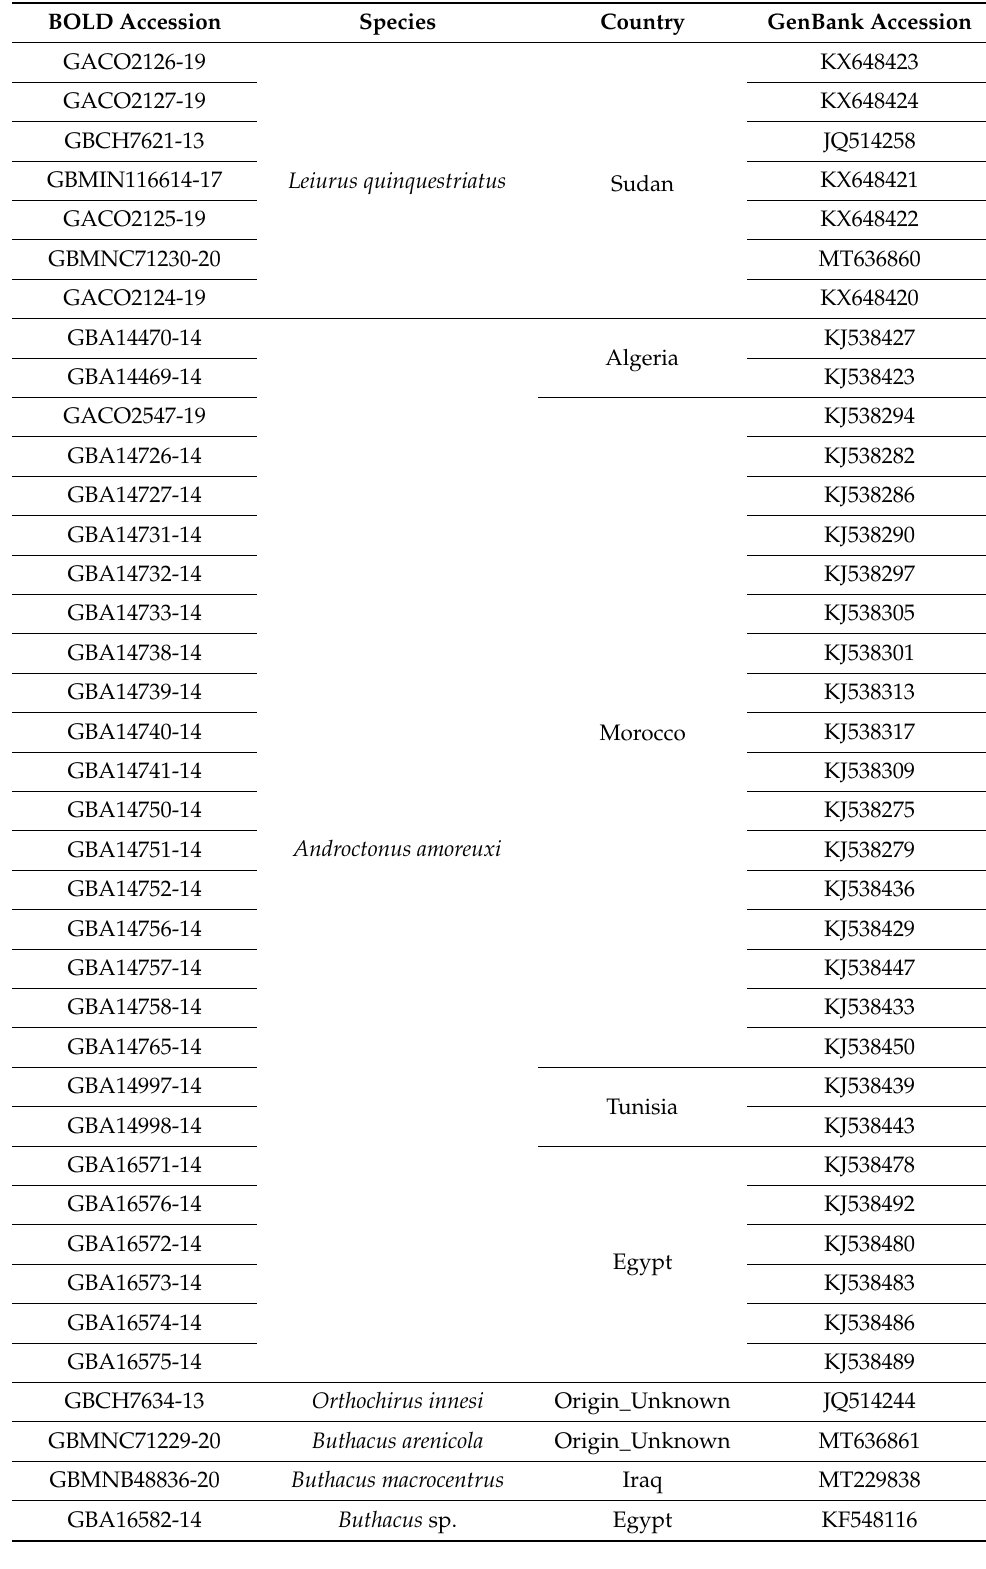
Table 1. Accession numbers, species and locations of sequences retrieved from BOLD/GenBank database for construction of phylogenetic